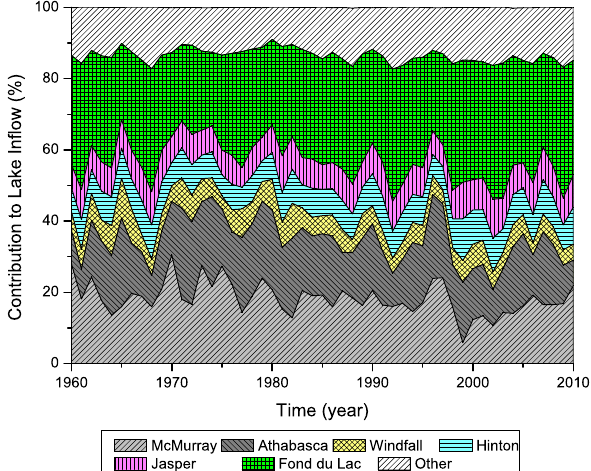
Fig. 2. Percentage of the annual contribution into Lake Athabasca inflow and hydrological regime variability in the Lake Athabasca basin over 1960–2010. There is a decline along the Athabasca River and a slight increase along the Fond du Lac River and other com- bined small rivers.